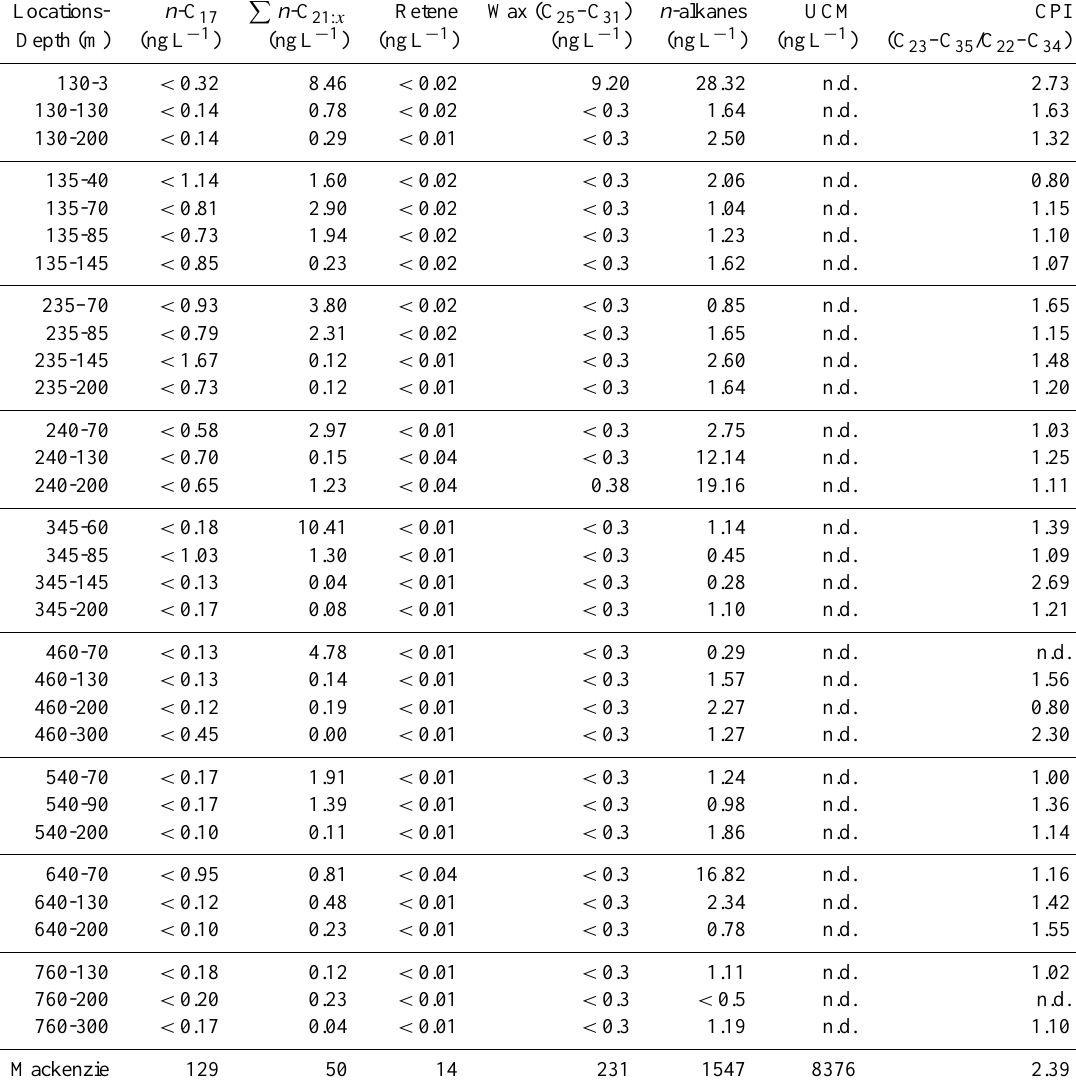
Table 3. Selected hydrocarbon concentrations and diagnostic ratios in suspended particle samples from the Beaufort Sea.